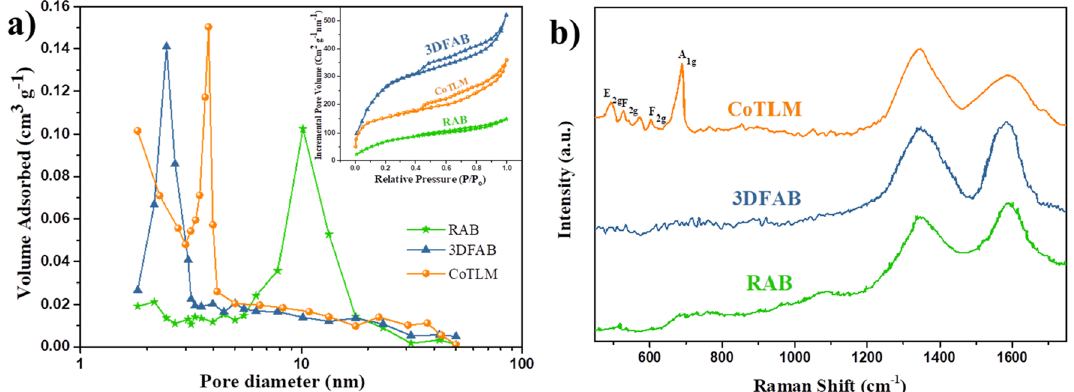
Figure 4. N 2 adsorption/desorption isotherm and pore size distributions (BJH) of the RAB, 3DFAB, CoTLM ( a ), Raman analyses ( b ).